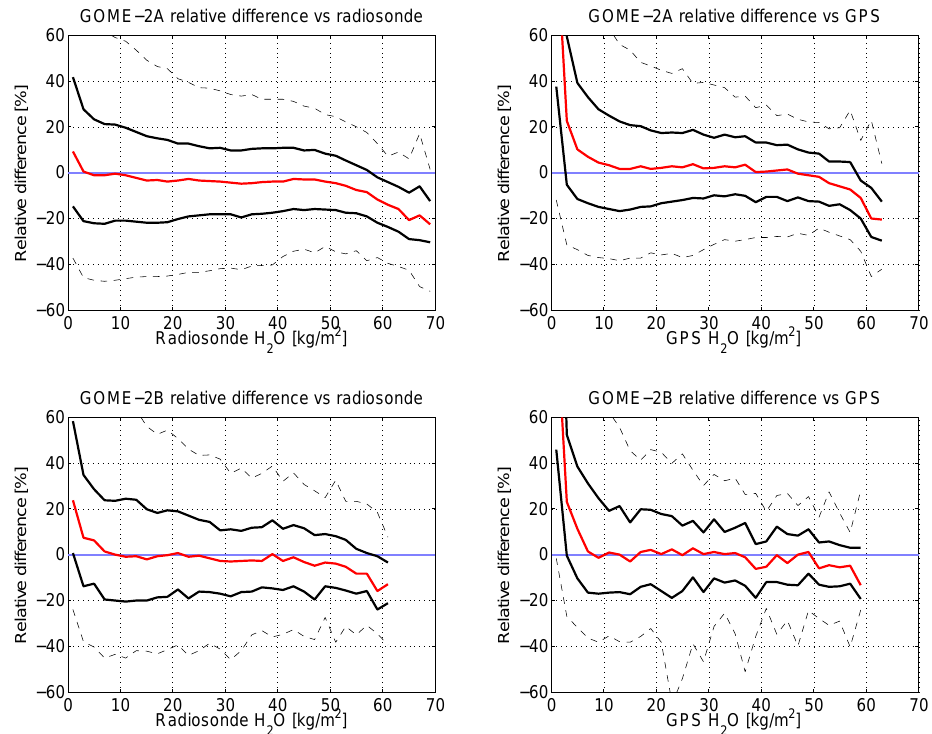
Figure 3. Median relative differences (red solid line), 25 and 75% percentiles (black solid lines) and 5 and 95% percentiles (dashed lines) for GOME-2A (top) and GOME-2B (bottom) against radiosonde (left) and GPS (right).